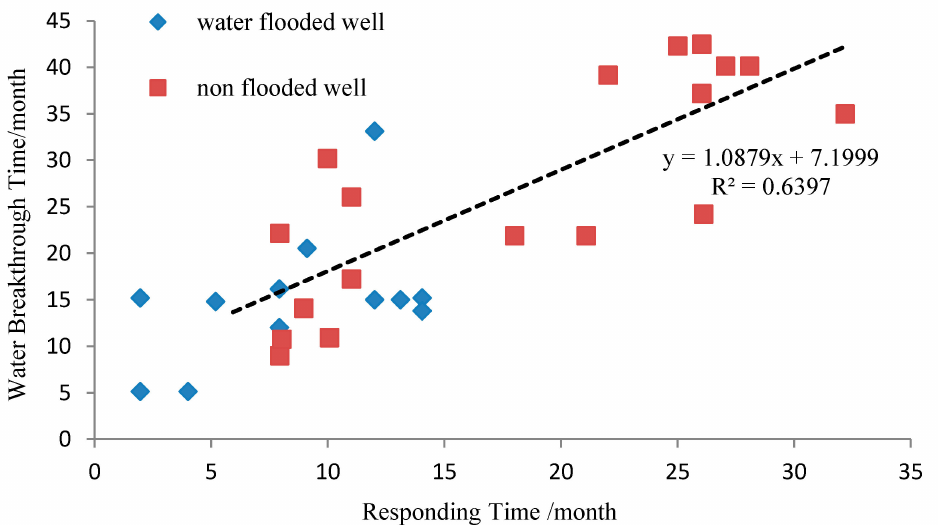
Figure 4. Comparison of water breakthrough time in oil